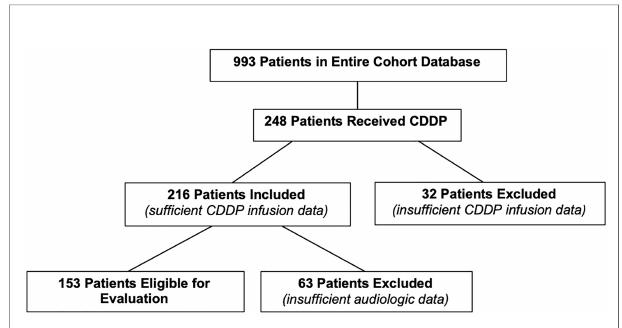
FIGURE 1 | CONSORT diagram outlining selection of eligible